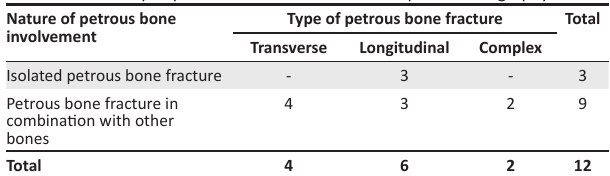
TABLE 4: Relationship between number of fracture lines and associated signs on computed tomography. Associated signs